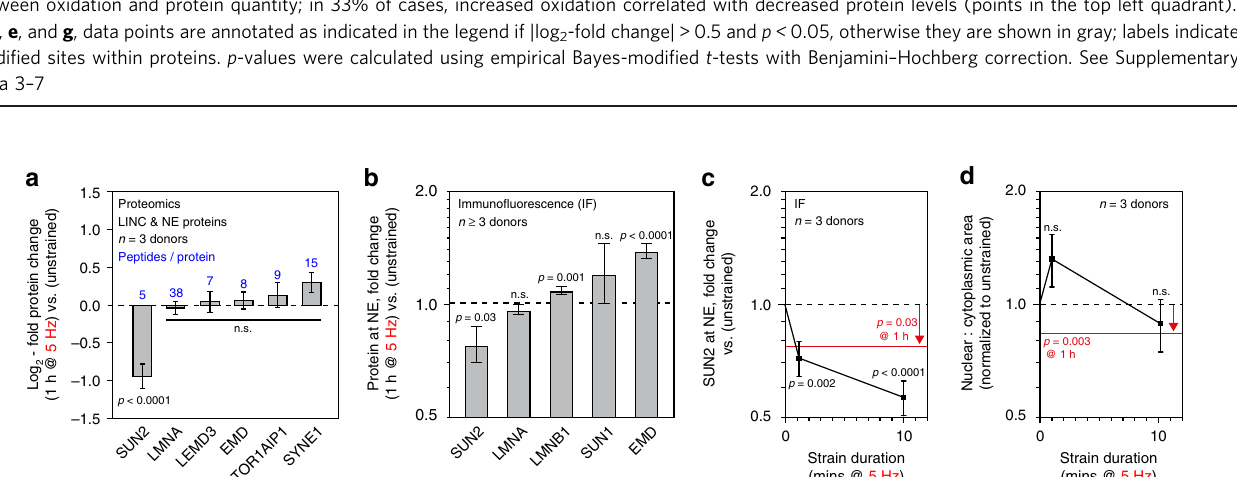
Fig. 3 Post-translational modi fi cation (PTM) states respond to CTS. a Schematic diagram of differential labeling of sulfhydryl groups by monobromobimane (mBBr) 1, 40 . Exposed cysteine residues are rapidly labeled, but those sequestered within folded proteins are unreactive; changes to the extent of labeling are indicative of altered protein conformation in response to a stress condition. Changes in protein quantity are determined by rates of synthesis versus turnover. b Histogram showing log 2 -fold changes to mBBr labeling site occupancy immediately and 24 h after hMSCs were subjected to CTS (1 h at 5 Hz, 2.6 – 6.2 % strain; n = 3 donors), relative to unstrained controls. The distribution immediately following CTS was broad and displaced to the right. After 24 h, the distribution was narrowed and centered around zero. Annotations indicate two sites within LMNA with signi fi cantly increased modi fi cation ( p < 0.05). c Correlation between changes to mBBr labeling site occupancy and the quantity of the parent protein (i.e. source of the labeled peptide), immediately following CTS. d Histogram showing changes to phosphosite occupancy immediately and 24 h after CTS (1 h at 5 Hz, 2.6 – 6.2% strain; n = 3 donors), relative to unstrained controls. All phosphorylation sites shown have been curated previously in the PhosphoSitePlus database 70 . The distribution was shifted to the right immediately following CTS. e Correlation between phosphorylation and protein quantity. f Histogram showing changes to oxidation-site occupancy immediately and 24 h after CTS (1 h at 5 Hz, 2.6 – 6.2 % strain; n = 3 donors), relative to unstrained controls. g Correlation